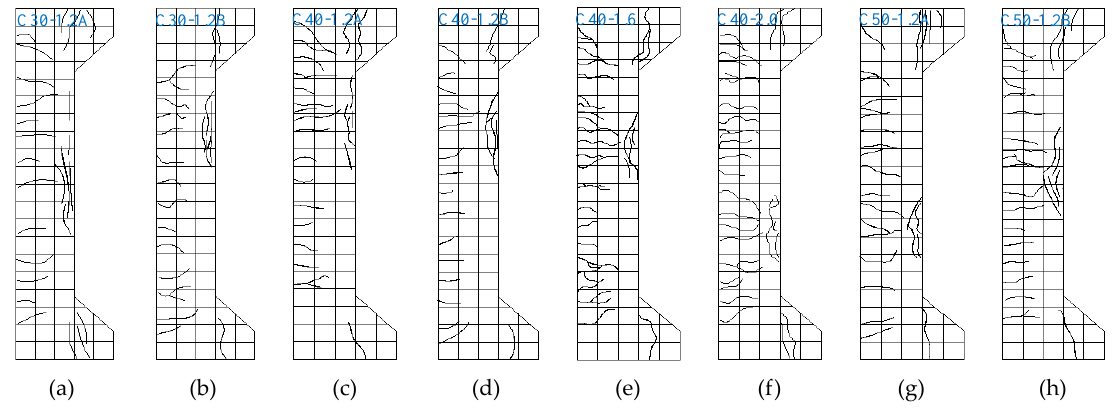
Figure 6. The failure modes of the columns: ( a ) C30 - 1.2A; ( b ) C30 - 1.2B; ( c ) C40 - 1.2A; ( d ) C40 - 1.2B; ( e ) C40 - 1.6; ( f ) C40 - 2.0; ( g ) C50 - 1.2A; ( h ) C50 - 1.2B.